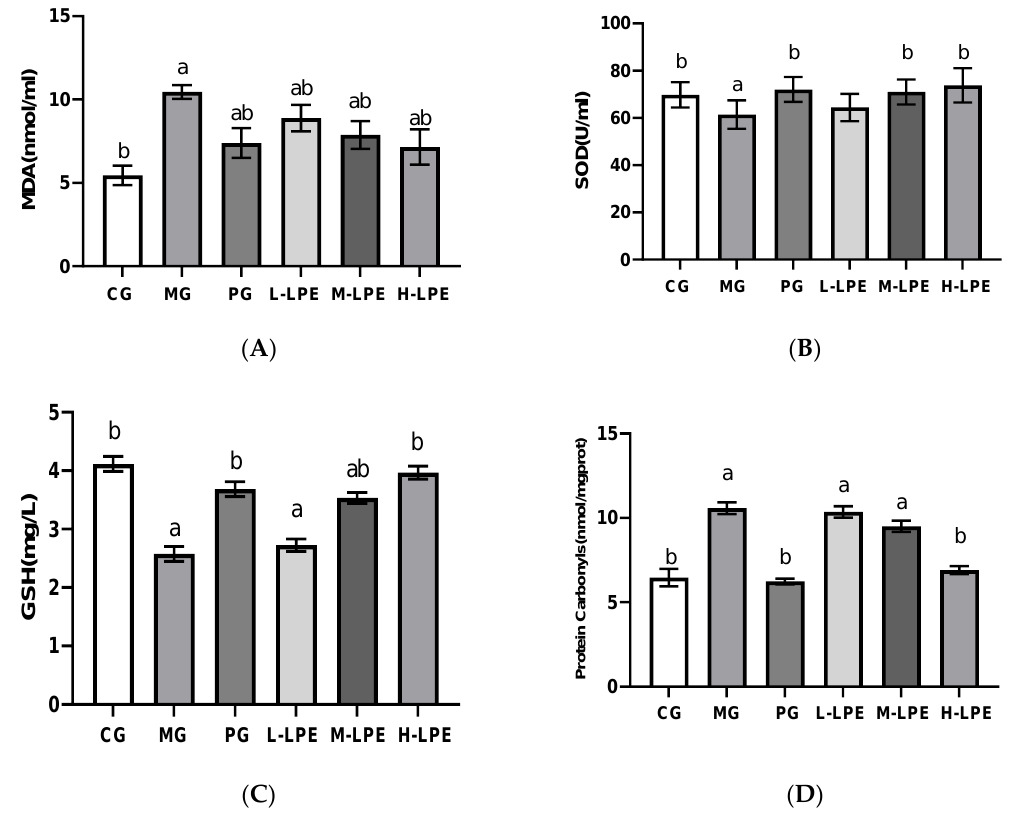
Figure 3. Levels of MDA, SOD, GSH and protein carbonyls in serum of mice: ( A ) MDA content in serum of mice; ( B ) SOD activity in serum of mice; ( C ) GSH content in serum of mice; ( D ) protein carbonyls content in serum of mice. Values are expressed as mean ± standard error ( n = 12 in each group). Values with different superscripts showed a difference with statistical significance, p < 0.05, “a” as a statistical difference compared with the blank control group, “b” as a statistical difference compared with the model group.